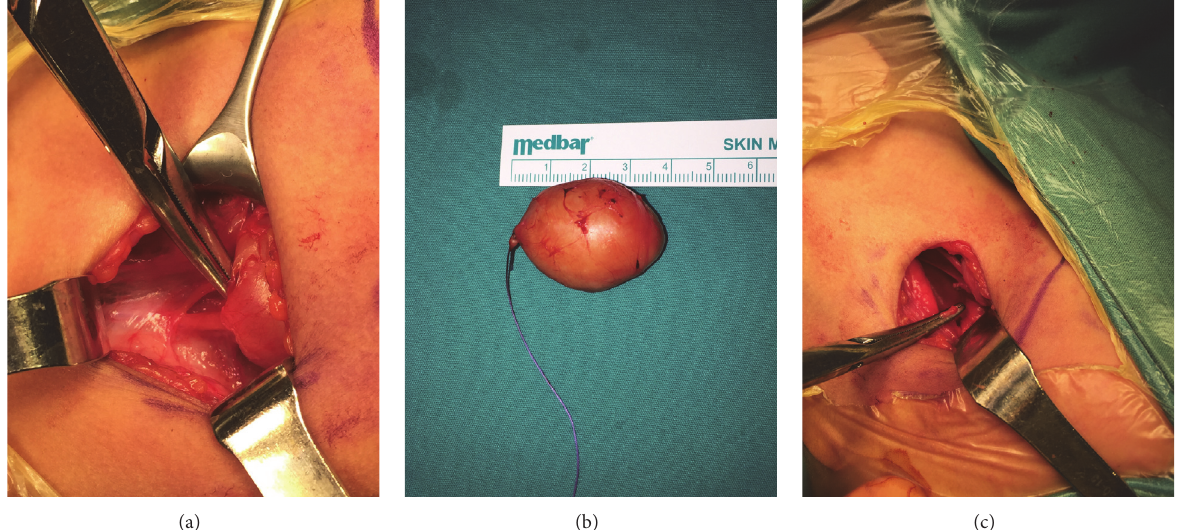
Figure 2: (a) Intraoperative view of the neurogenic mass. (b) The lesion with 4 cm size after the total excision. (c) Upper part of the nerve was held by the clamp.